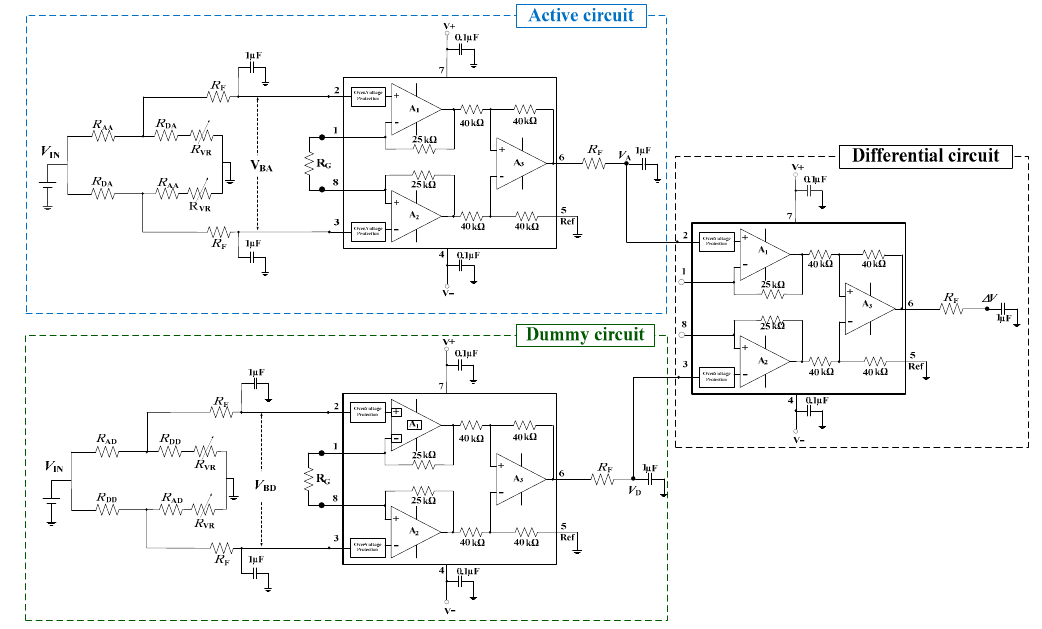
Figure 5. Design of the amplifier circuit by the active-dummy method.